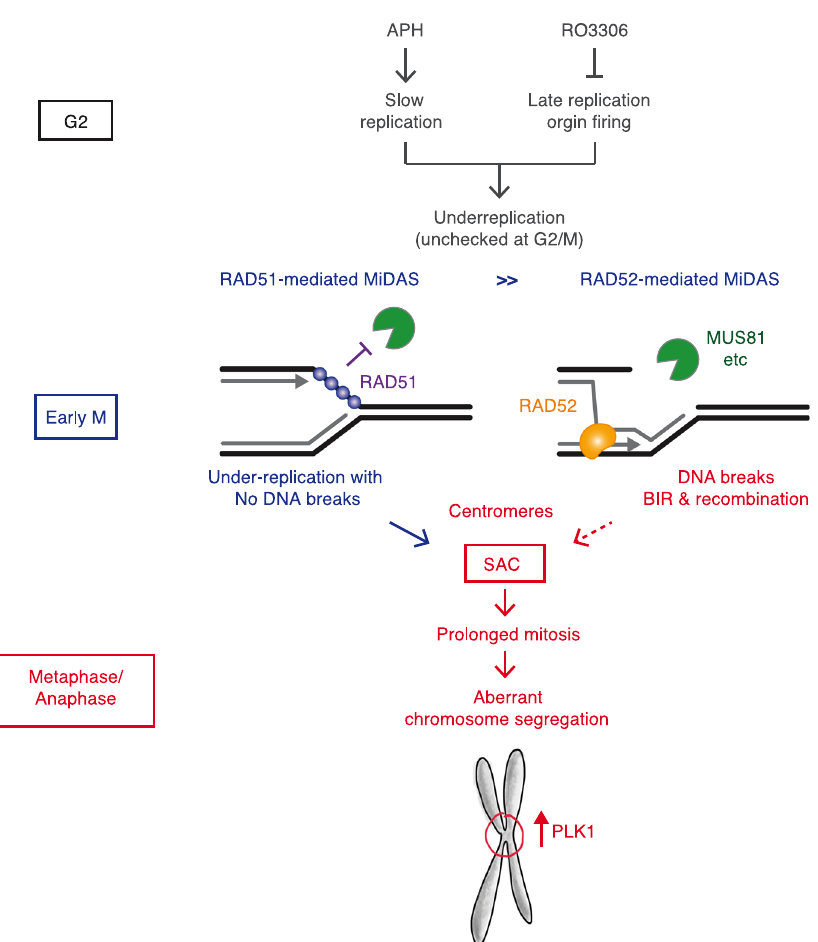
Fig. 7 Model. Mild replicative stress (i.e., 0.4 µ M aphidicolin) and the suppression of late origin fi ring (i.e., RO3306) may result in substantial under- replication, which is undetected by the G2/M checkpoint. As cells move into mitosis, RAD51 is recruited to ssDNA at replication forks in a manner dependent on PLK1, and protects them from the attack of mitotic nucleases, such as MUS81, hence allowing the completion of DNA replication. This is distinctive from the RAD52-mediated MiDAS, which occurs downstream of mitotic DNA breaks. Centromeric under-replication prevents SAC inactivation until resolved by MiDAS. RAD51-mediated protection of centromeric DNA, which is enriched with PLK1, hence ensures appropriate chromosome